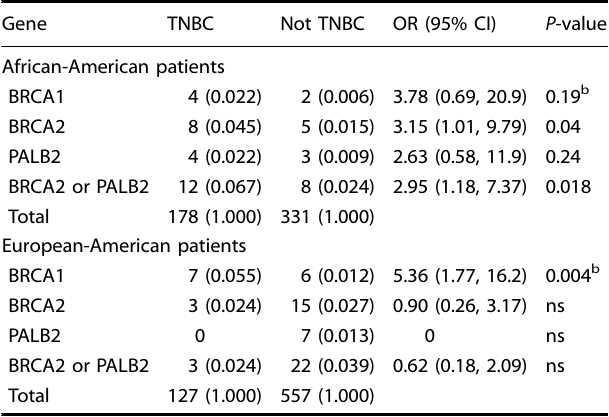
Table 4. Odds ratios for TNBC versus breast cancer of other subtypes for patients with pathogenic variants in BRCA1, BRCA2, or PALB2 a . Gene TNBC P